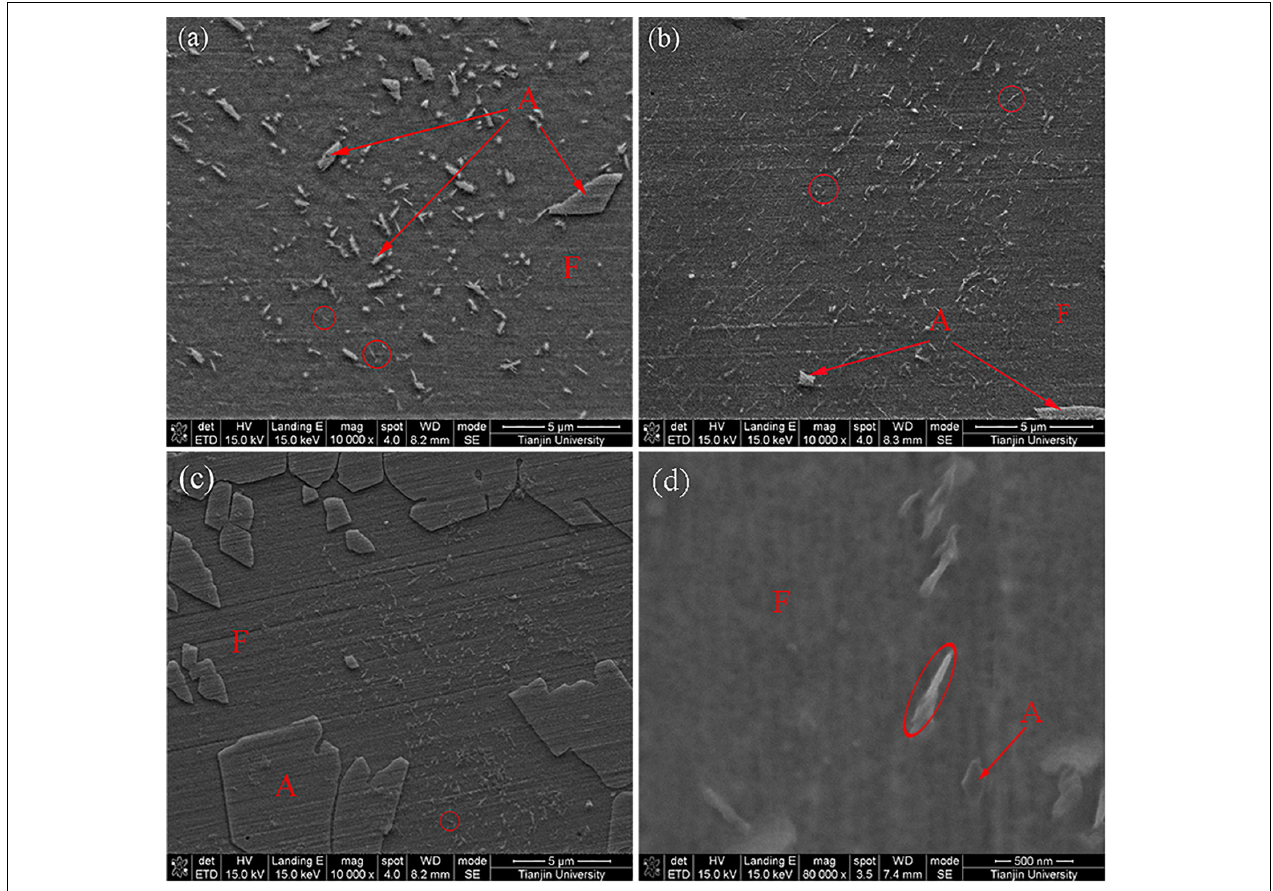
FIGURE 4 | The precipitates observed by SEM: (a) the fine precipitates in the weld cap; (b) the weld root; (c) the HAZ; (d) the HAZ in high